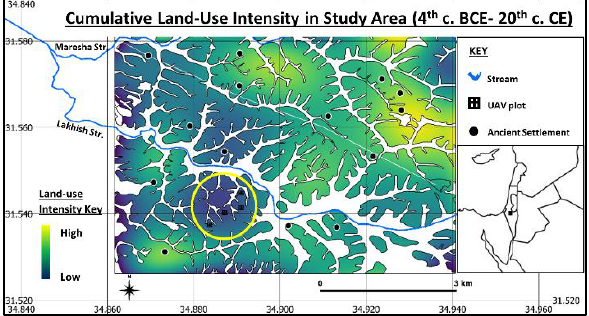
Figure 1. 2300 years cumulative land-use intensity in the study area from trend analysis with major ancient settlements and location of UAV vegetation plots in Gad Hills reserve